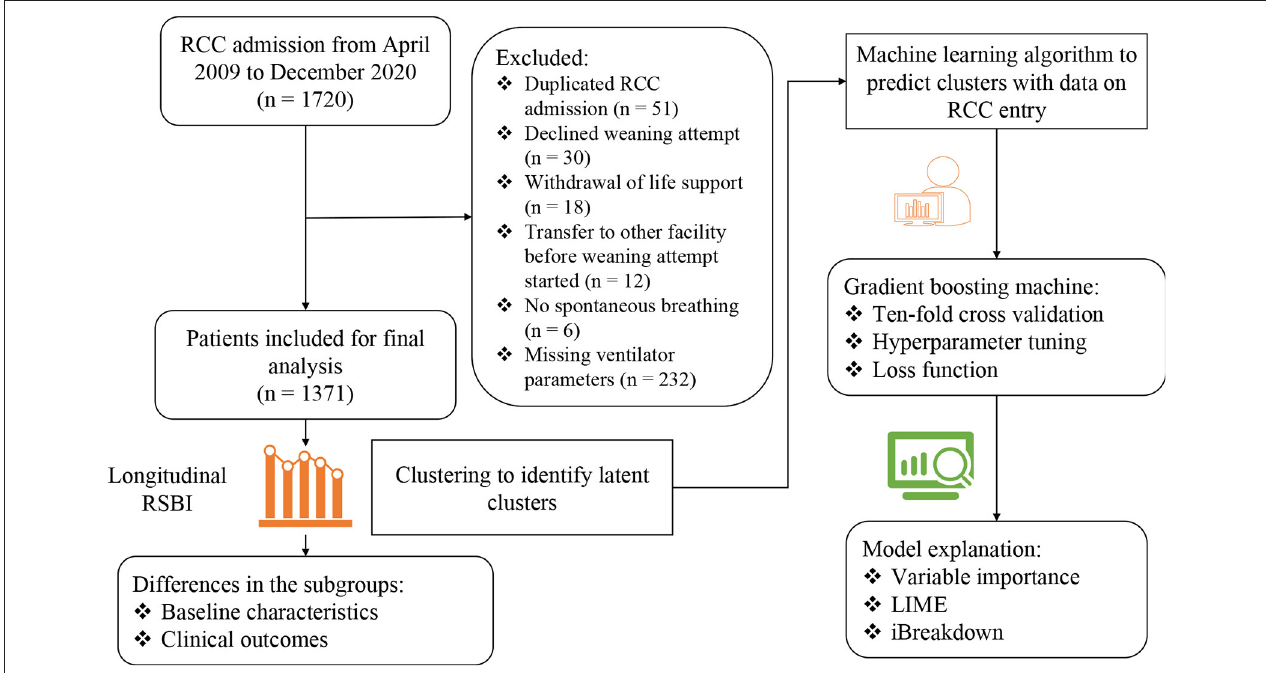
FIGURE 1 | Flowchart of patient enrollment and schematic illustration of the analysis workflow. RSBI, Rapid shallow breathing index; RCC, respiratory care center; LIME, local interpretable model-agnostic explanations.